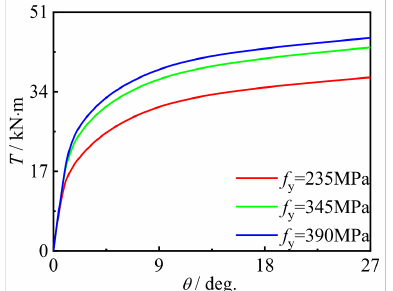
Figure 22. Effect of f y on T - θ curve.